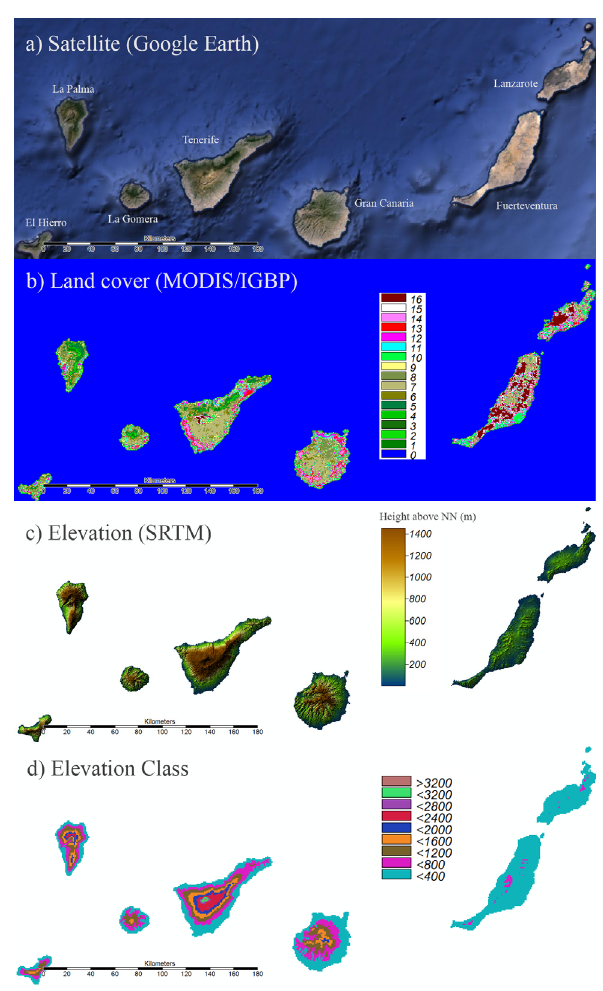
Figure 2. a) Satellite image (Google Earth); b) Land cover